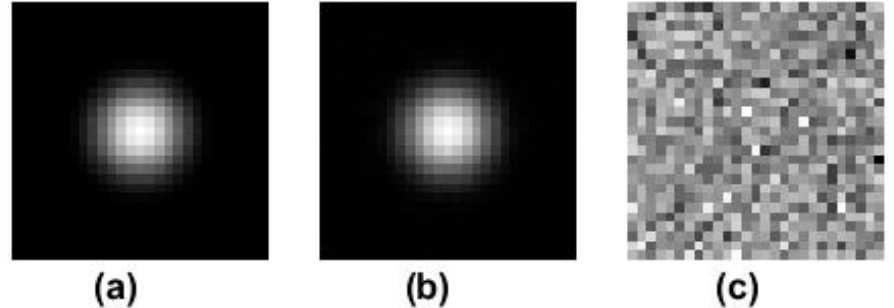
Figure 6. Results of the point spread function in Figure 2 (SNR = 40 dB, Sampling Ratio = 0.8). ( a ) the point spread function; ( b ) the estimated point spread function; ( c ) the difference between point spread function and the estimated point spread function.